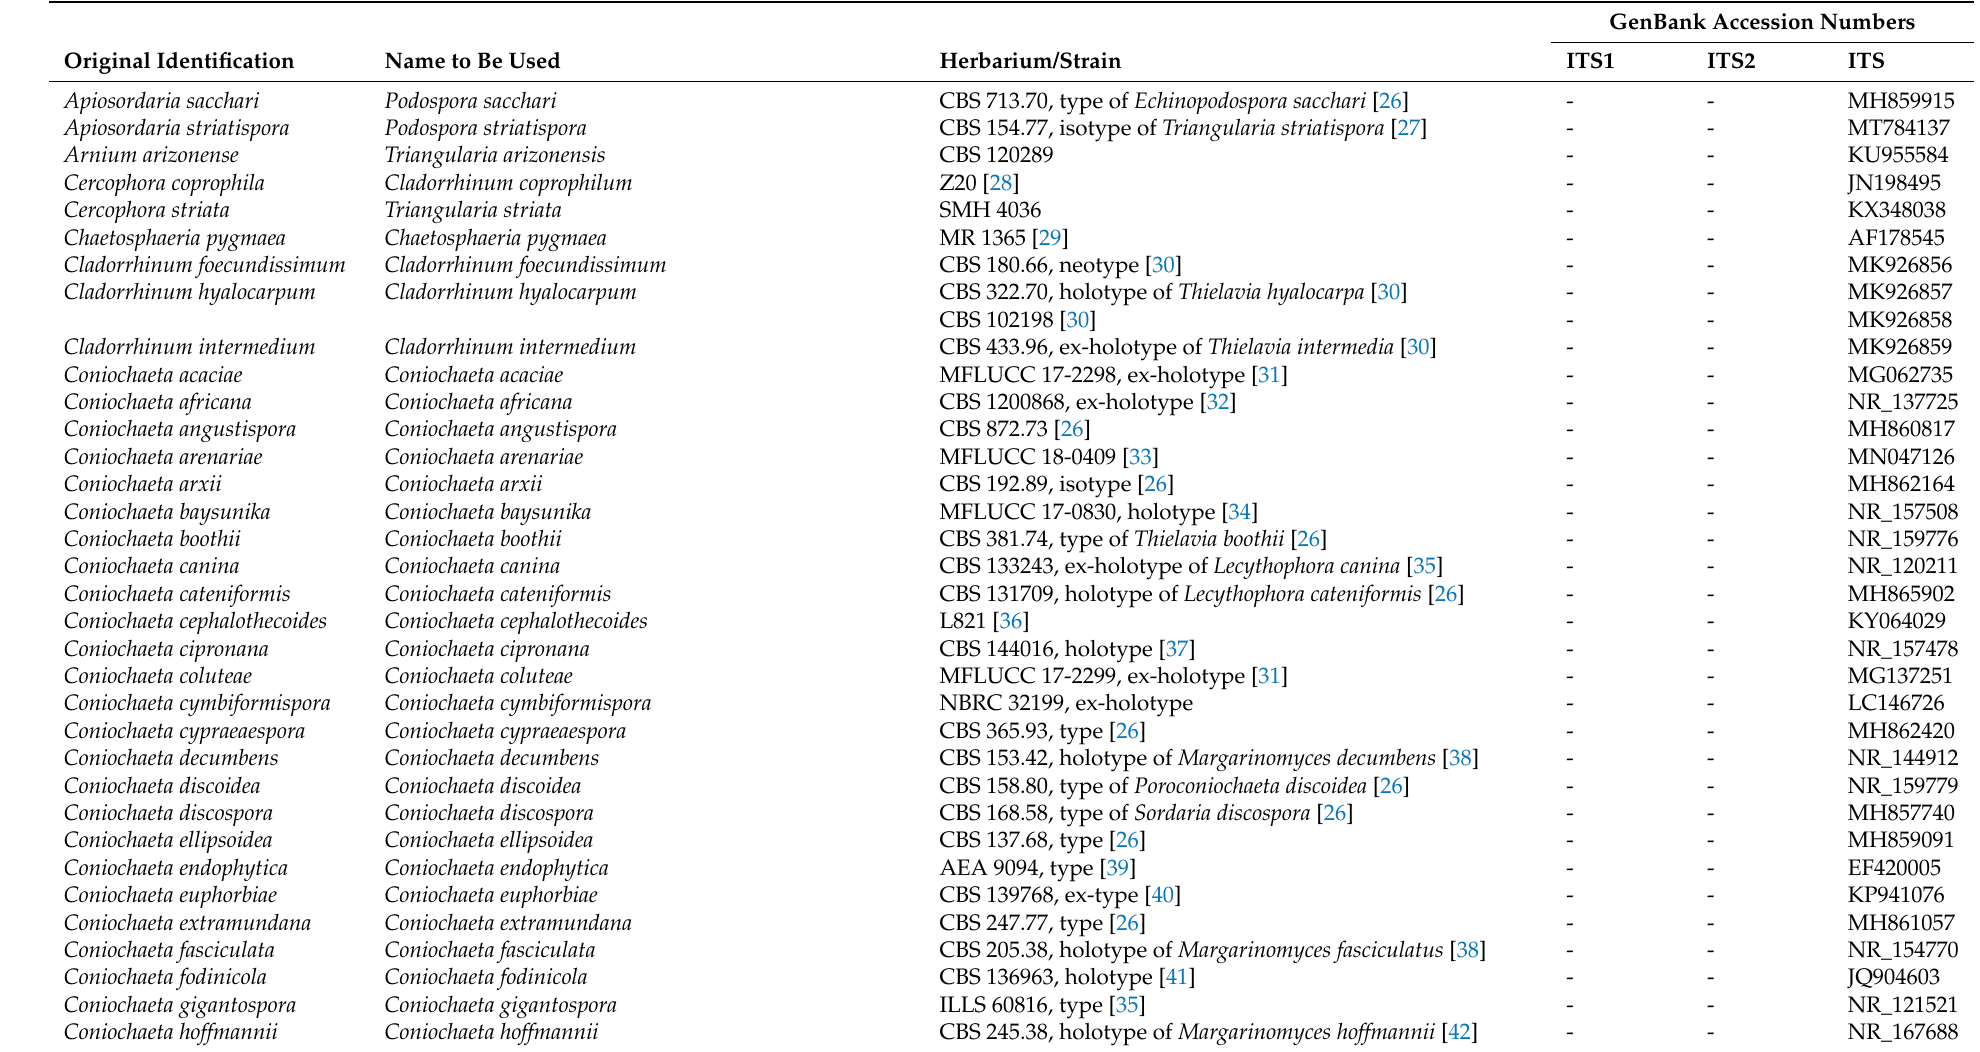
Table 1. List and details of Coniochaeta and Podosporaceae specimens used in the internal transcribed spacer (ITS) phylogenetic analyses. Newly obtained sequences are reported in bold .